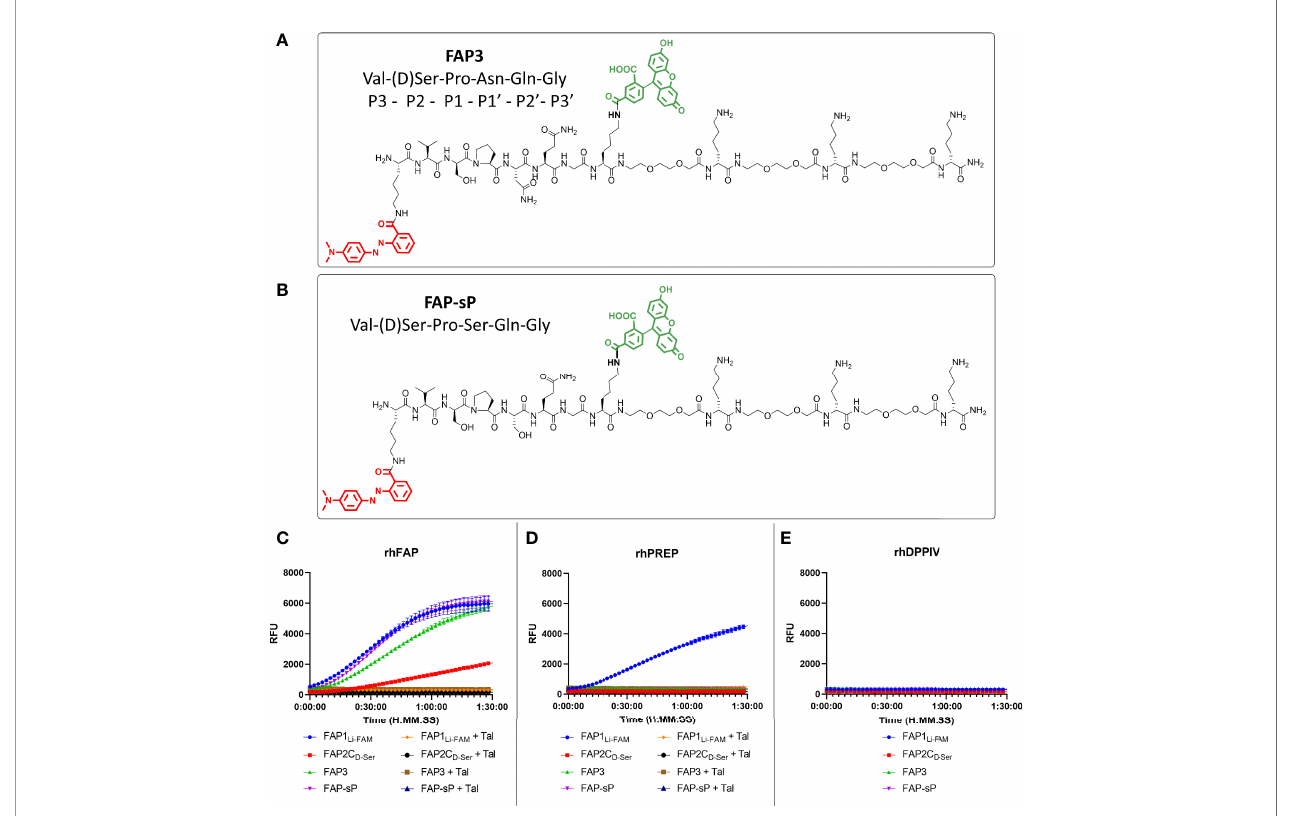
FIGURE 3 | FAP3 assessment against FAP-sP demonstrates FAP speci fi city. (A) The structure of FAP3; (B) The structure of FAP-sp; (C) Assessment of FAP3 and FAP-sP (all 5µM) when compared to prior iterations.; (D) rhPREP assessment demonstrating no rhPREP cleavage for FAP3 or FAP-sP; (E) DPPIV assessment demonstrating no exopeptidase activity. Representative plots, n=3 for each experiment run in